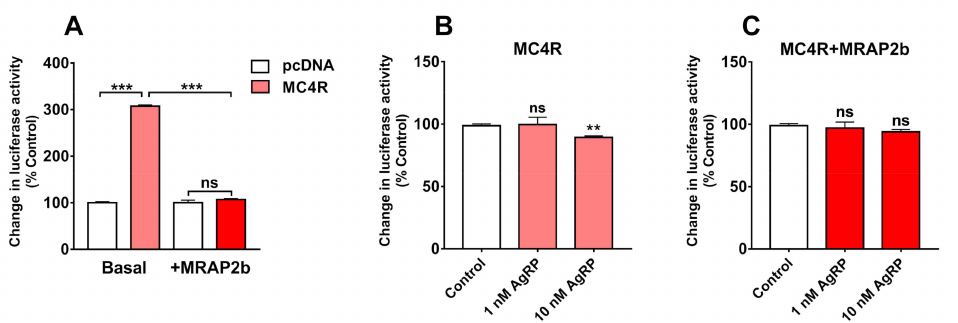
Figure 7. The action of MRAP2b on the basal constitutive activity of tilapia MC4R, as detected by dual-luciferase reporter assay. ( A ) The basal constitutive activity of tilapia MC4R was observed compared to pcDNA3.1 ( + ) vector control; however, its basal constitutive activity was reduced in the presence of tilapia MRAP2b. ( B , C ) The e ff ect of human AgRP (1 nM and 10 nM, 6 h) on the basal luciferase activities of CHO cells expressing tilapia MC4R ( B ), or CHO cells co-transfected with MC4R and MRAP2b plasmids at a ratio of 1:5 ( C ), as monitored by dual-luciferase reporter assay. Data are shown as mean ± SEM of four replicates ( n = 4). **, p < 0.01. ***, p < 0.001. ns, no significant di ff